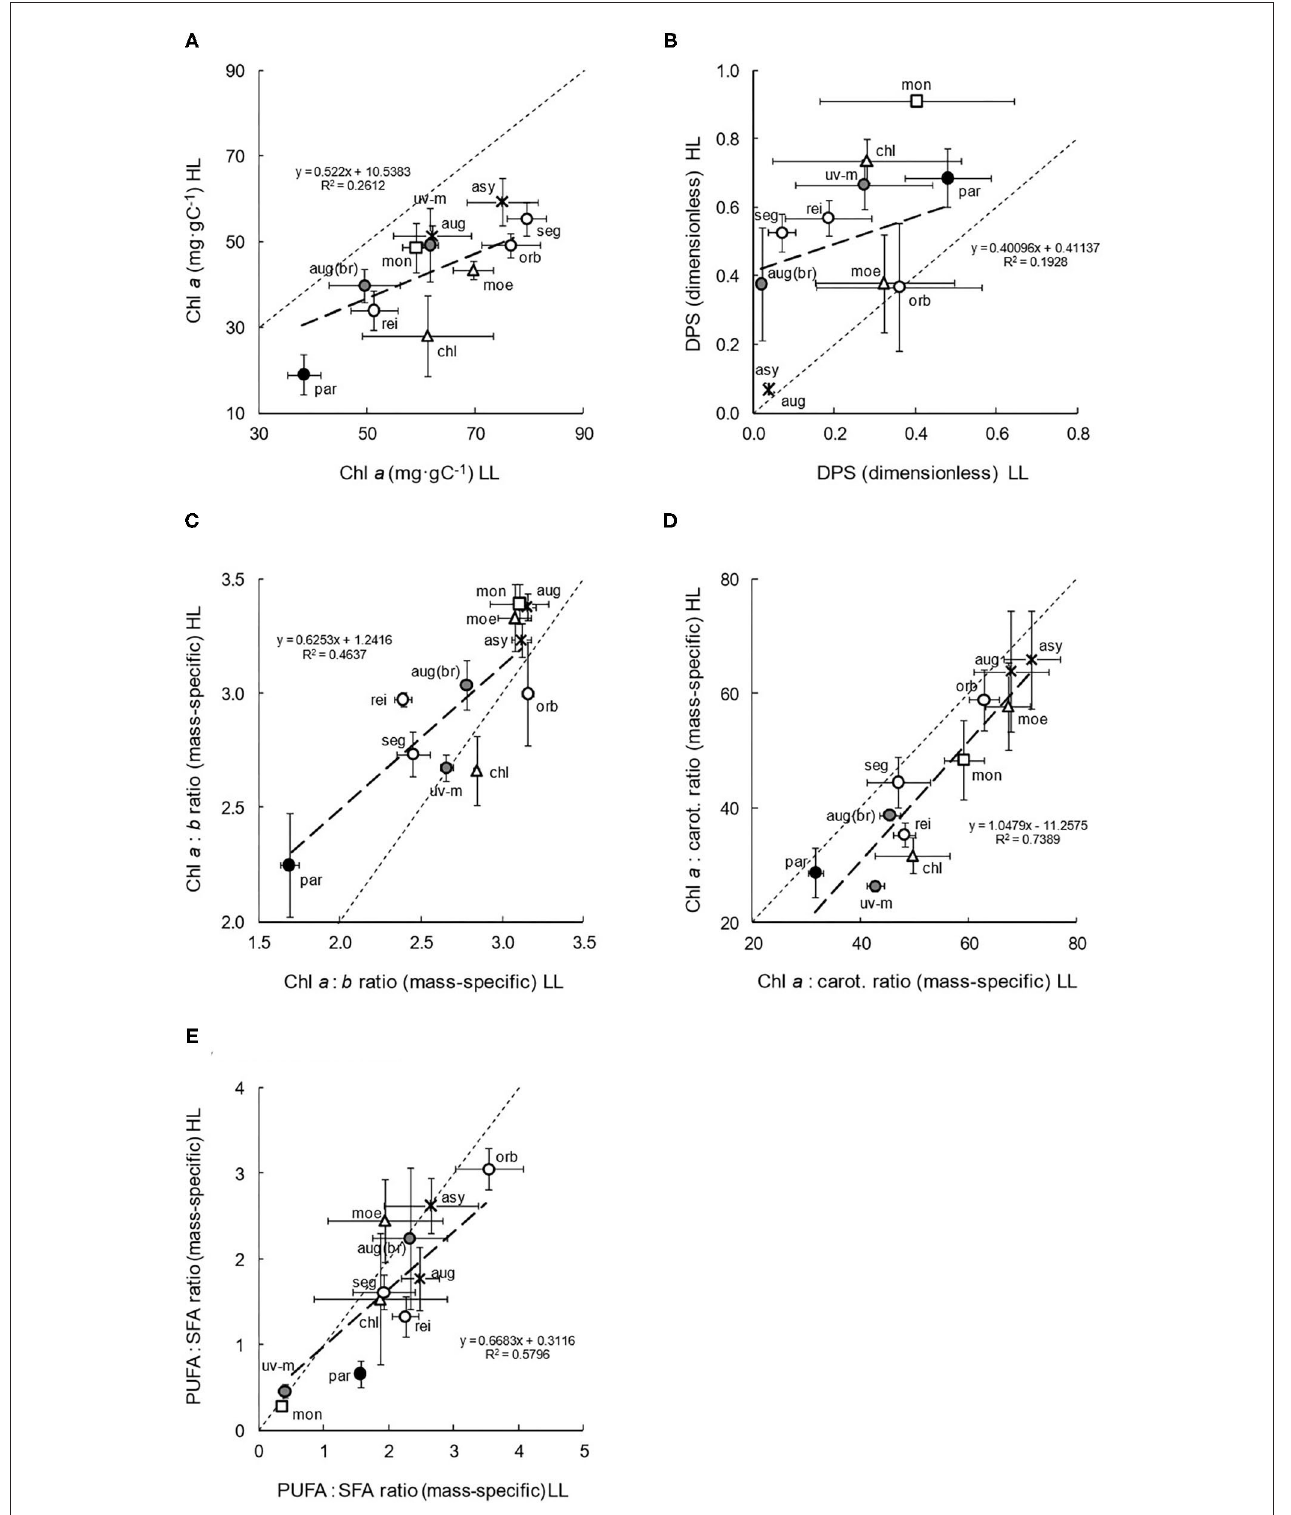
FIGURE 3 | Compositional characteristics (A–E) of the 11 species of Chlamydomonas grown under conditions of low light (LL) and high light (HL). Mean values and standard errors are presented, with ratios in (C–E) being mass-specific (e.g., mg · gC − 1 ). Thin dashed lines represent theoretical 1:1 ( x = y ) relationships between